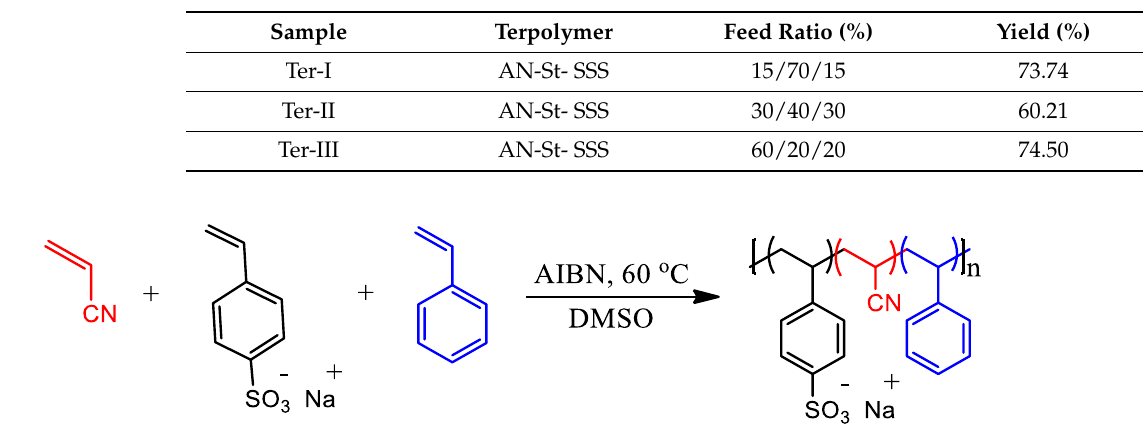
Table 1. Polymerization results of terpolymers Ter-I, Ter-II, and